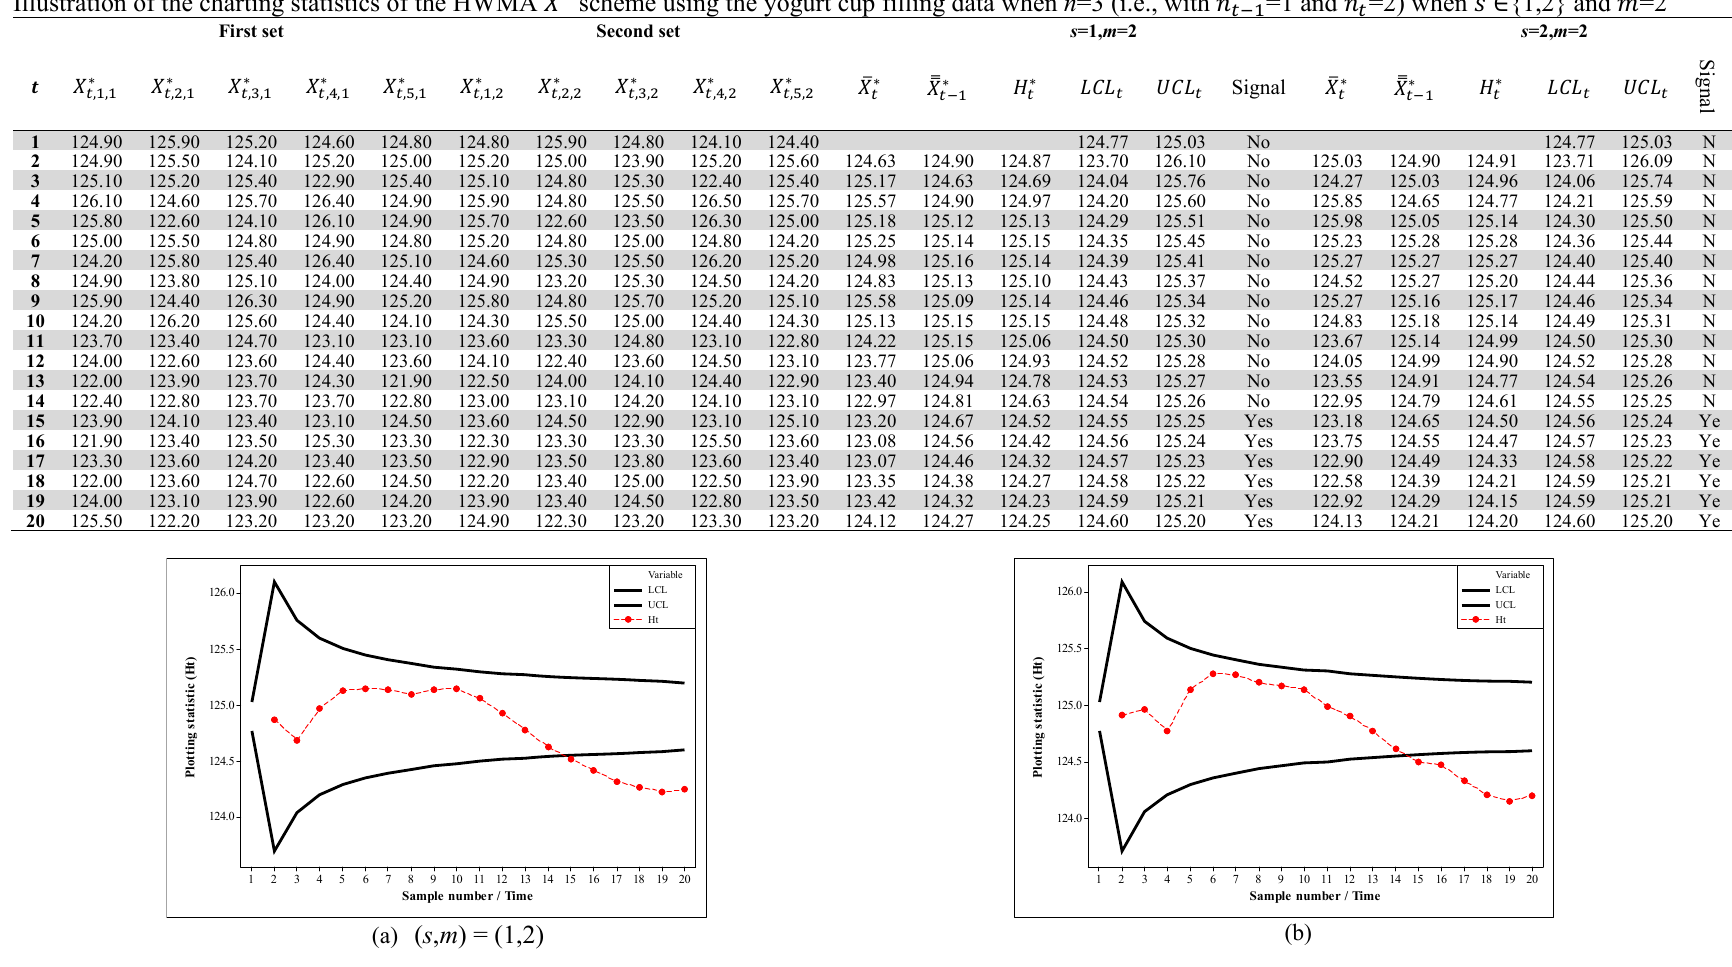
Fig. 7. HWMA 𝑋(cid:3364) ∗ scheme using the mixed- s & m strategy for the yogurt cup filling data when n =3 (i.e., with 𝑛